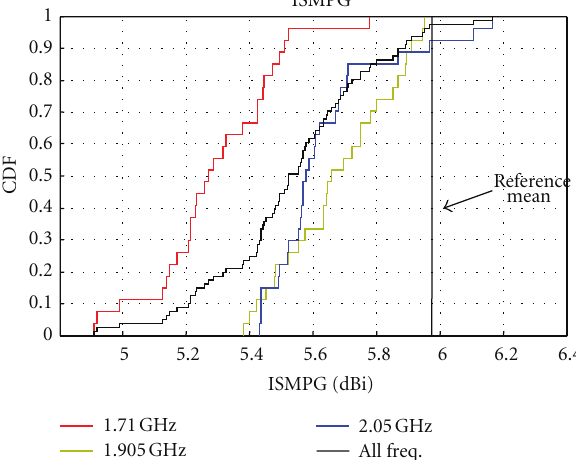
Figure 10: ISMPG distribution over all realizations for the patch- wall perpendicular scenario. Table 2: Parameters of dipole-wall